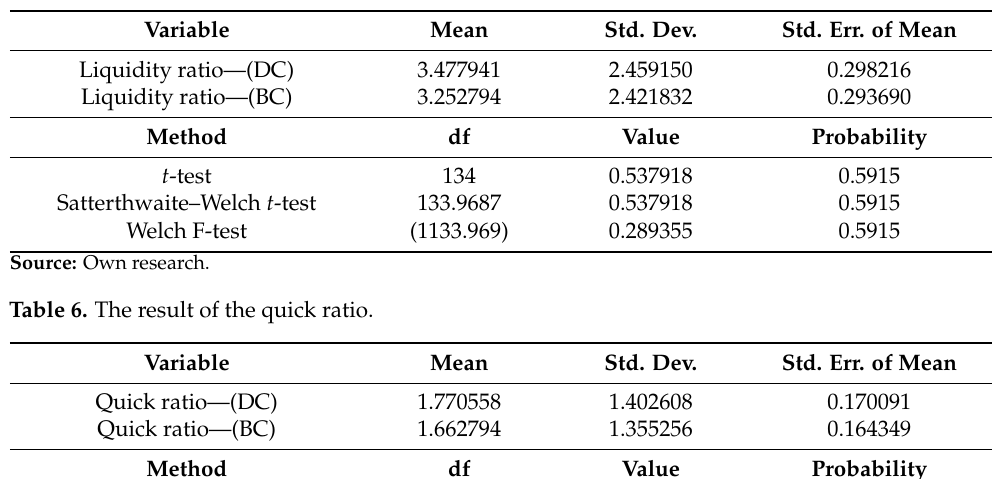
Table 5. The result of the financial liquidity ratio.